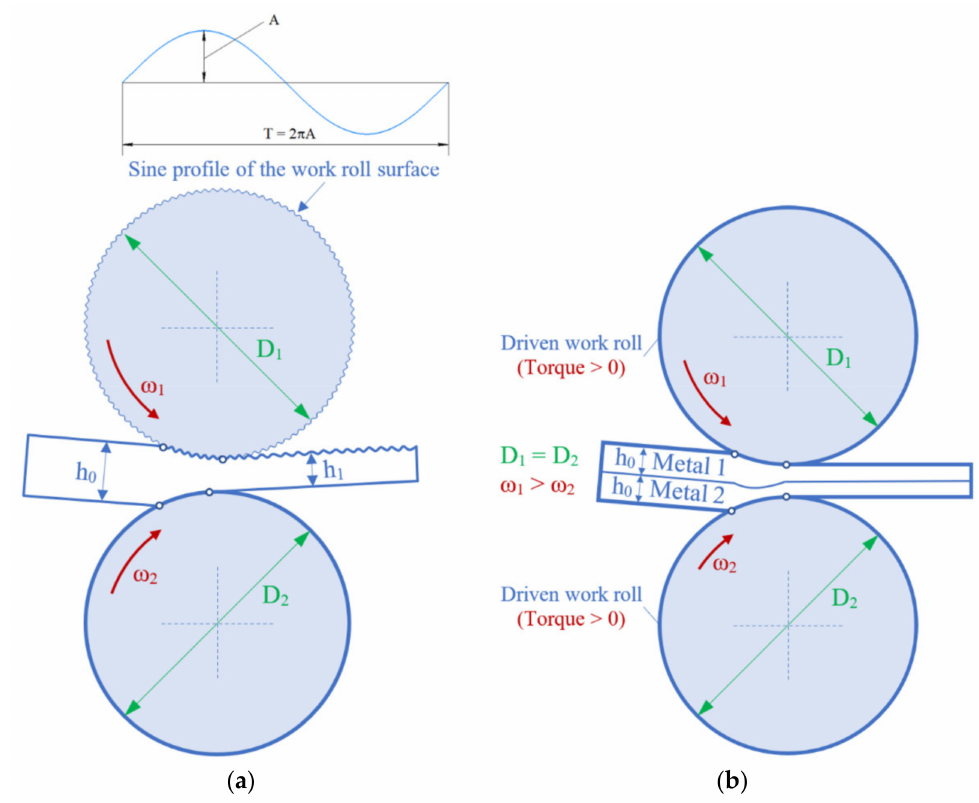
Figure 11. Schematic illustration of periodical straining rolling ( a ) and asymmetric roll bonding of bimetal layered composites ( b